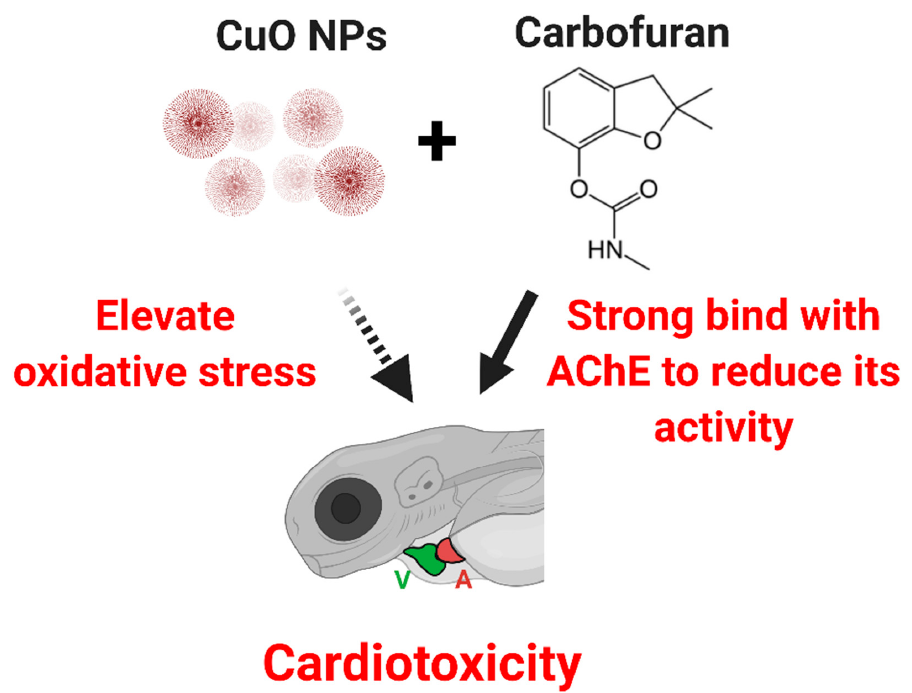
Figure 10. Proposed model for cardiotoxicity triggered by CuO nanoparticle and carbofuran co-incubation in zebrafish larvae (A = atrium, V = ventricle). The solid line indicates direct evidence provide by our molecular docking data, while dotted line indicates indirect evidence collected from literature.